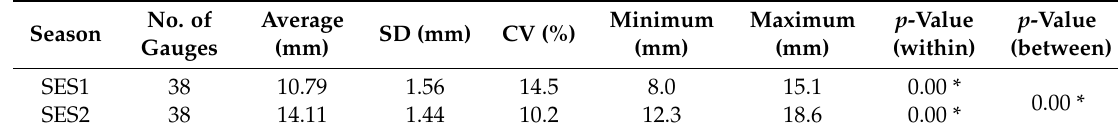
Table 1. Analysis of average spatial rainfall (mm) per event within and between seasons.